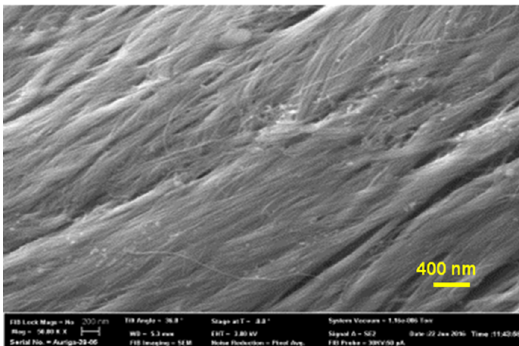
Figure 3. SEM images of CNT yarn e-beam irradiated at 600 kGy - a and b. In Figure 4 SEM images are presented from the pristine samples (Figure 4a) and the samples e-beam irradiated at 800 kGy (Figure 4b, c and d). The yarn irradiated at